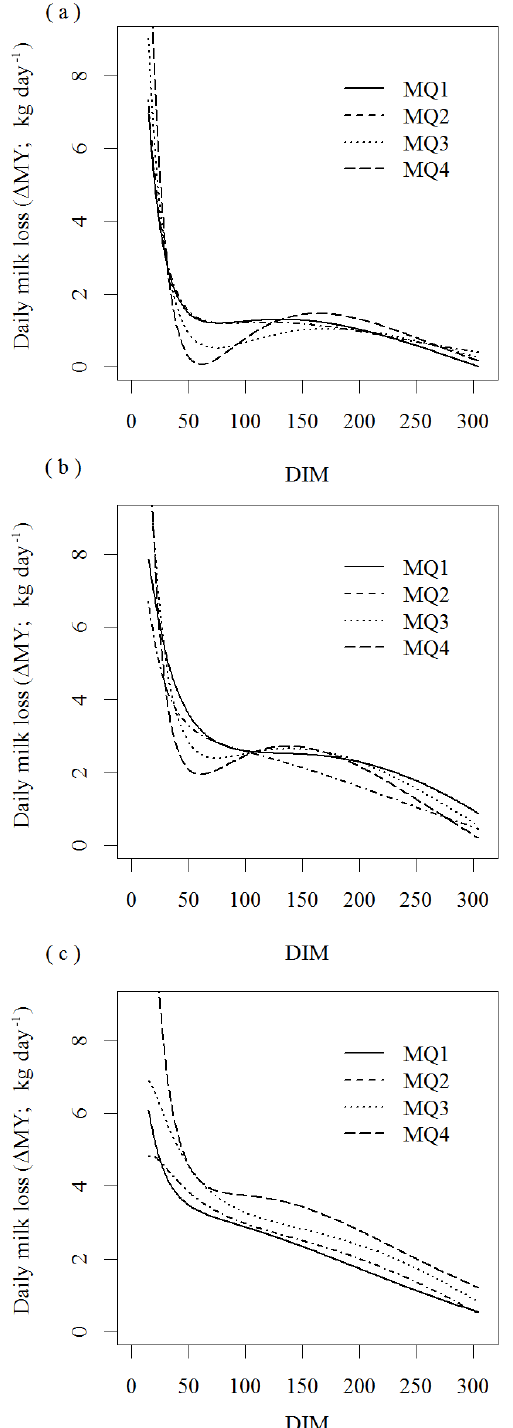
Figure 2. Estimated daily milk yield loss (kgDIM − 1 ) for different milk production levels (MQ) and the specific value of 300000 so- matic cell count (SCC) in consecutive lactations – (a) first parity, (b) second parity, and (c) ≥ third parity. Jeretina et al.